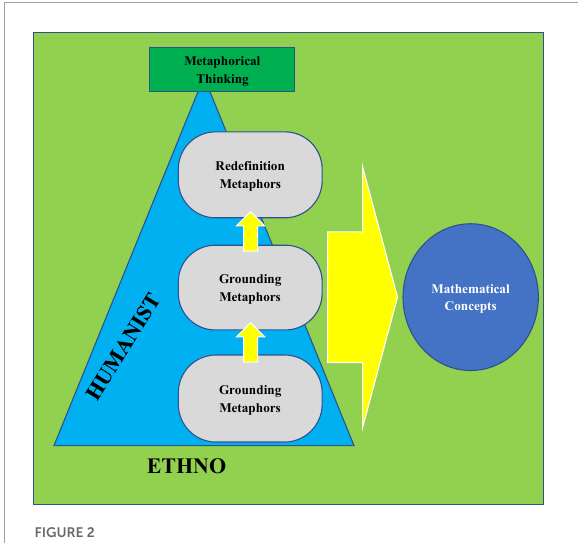
FIGURE2 Humanist ethno-metaphorical mathematics learning